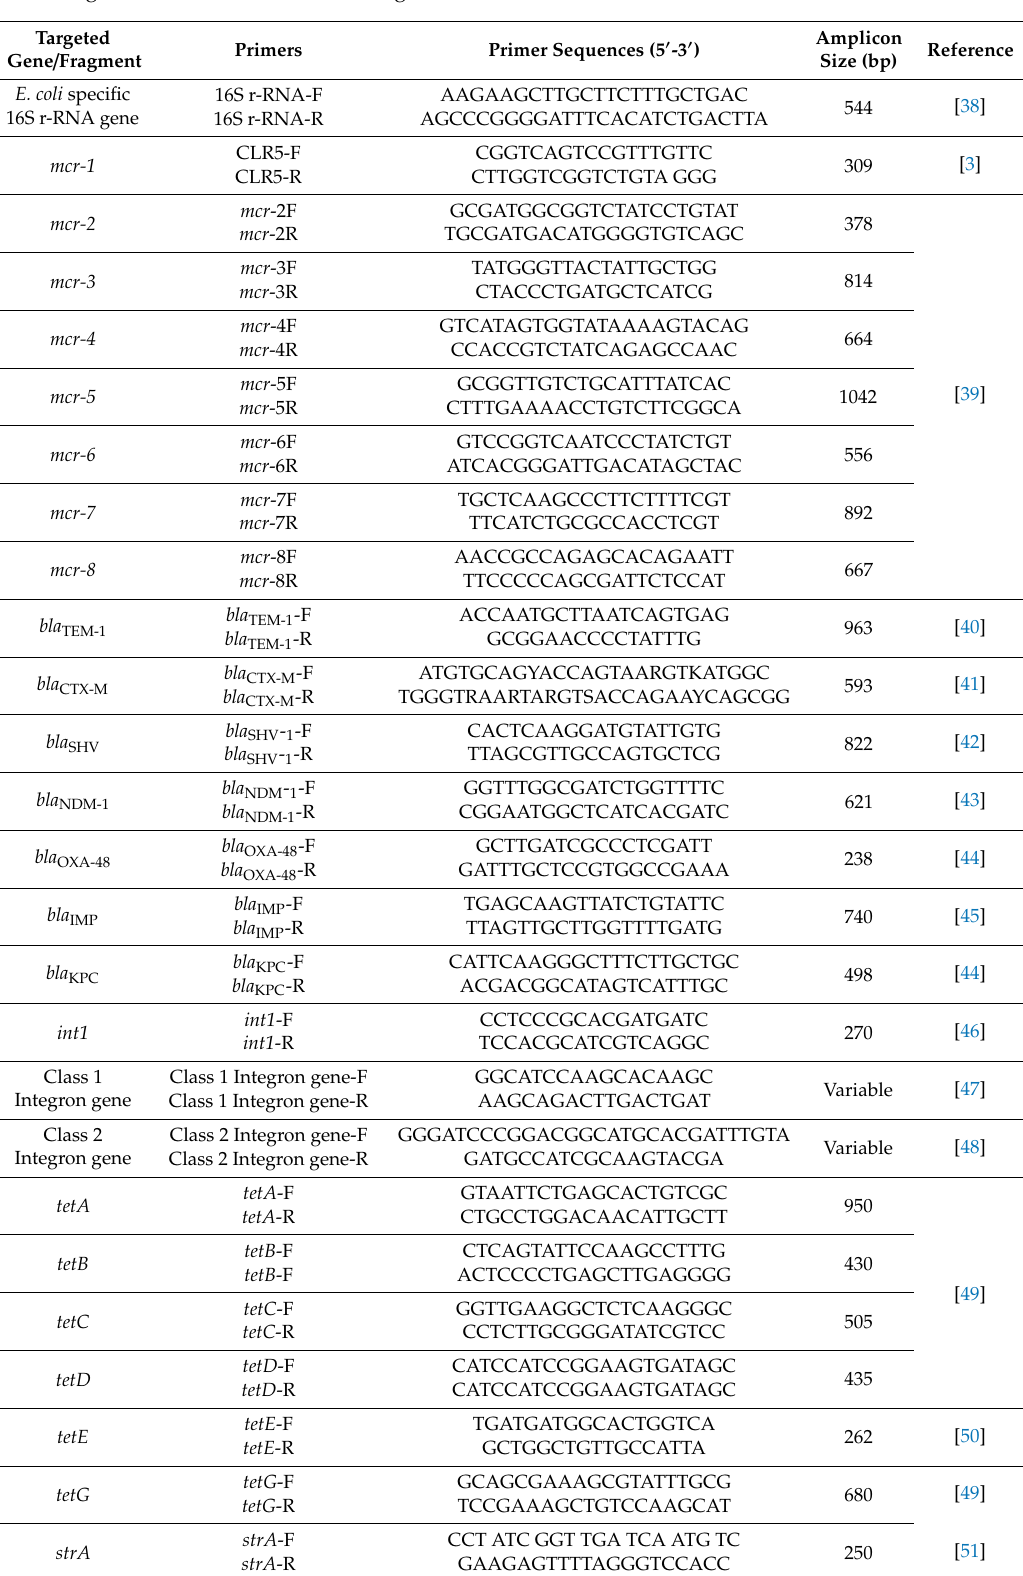
Table 1. Primers and polymerase chain reaction (PCR) conditions used for screening the E. coli isolates for mcr genes and other relevant AMR